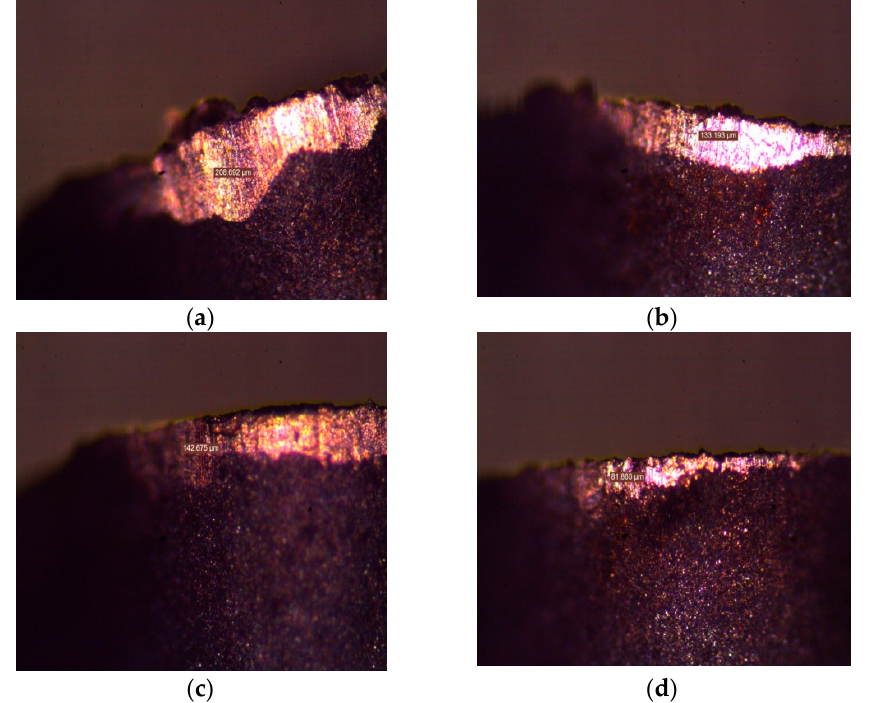
Figure 4. Comparison of VBmax for the tools found under MQL and VMQL [47]. ( a ) Condition: MQL, v c = 275 m/min, f = 0.13 mm/rev, a e = 0.30 mm; ( b ) Condition: MQL, v c = 250 m/min, f = 0.05 mm/rev and a e = 0.40 mm; ( c ) Condition: VMQL, v c = 275 m/min, f = 0.13 mm/rev, a e = 0.30 mm; ( d ) Condition: MQL, v c = 250 m/min, f = 0.05 mm/rev and a e = 0.40 mm.